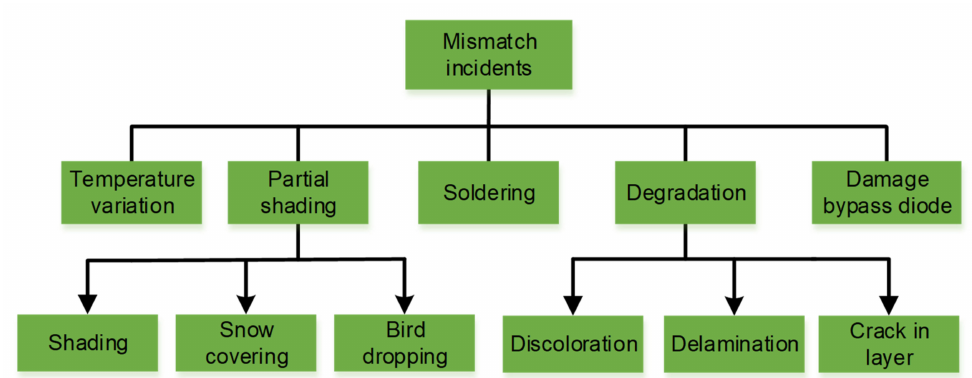
Figure 2. Mismatch incidents and their causes.